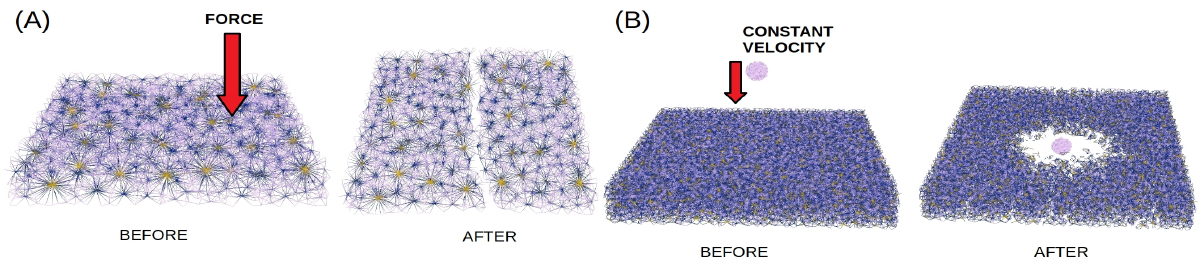
Fig. 14: Exemplary presentation of the numerical slab after two different tests: